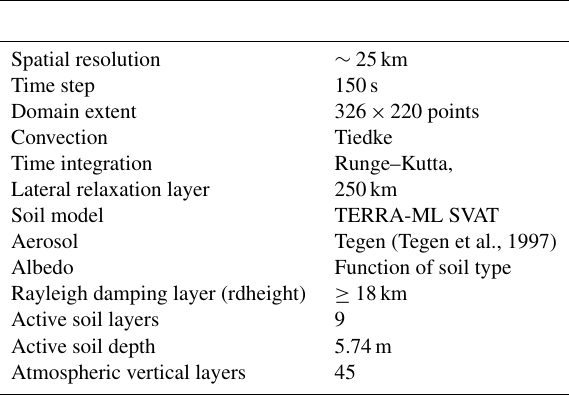
Table 2. General description of model setup of the reference simu- lation